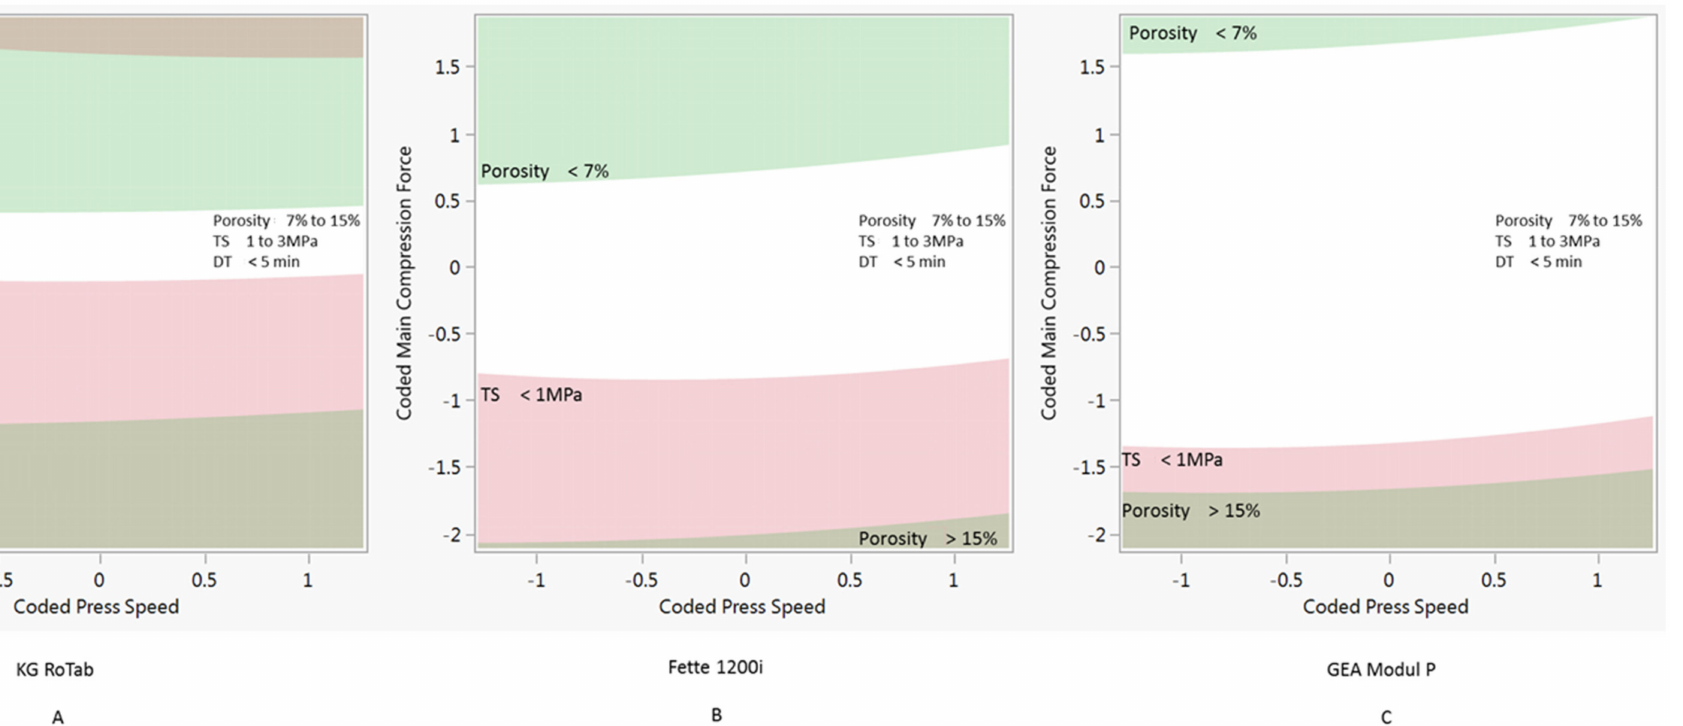
Figure 5. Two-dimensional contour profiles showing optimum process conditions for tablet tensile strength, porosity and disintegration time for formulation 3 at a set pre-compression force of 1 kN. ( A ) KG RoTab, ( B ) Fette 1200i and ( C ) Modul P. Coded main compression force and coded press speed values correspond to standardised units (Section 2.6). DT indicates disintegration time, and TS represents tensile strength. Regions of main compression force and press speed settings at which the tablets produced meet the target specifications of porosity 7% to 15%, tensile strength 1 to 3 MPa and disintegration time < 15 min are in white. Regions of main compression force and press speed settings at which the tablets produced were outside target specification are indicated by different shaded